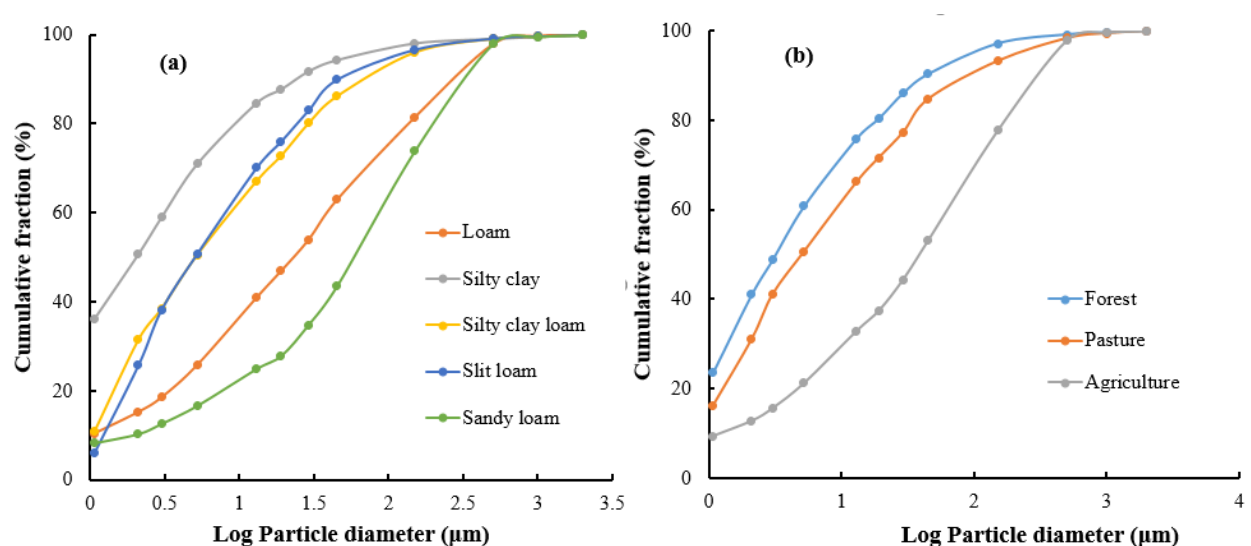
Figure 4. Log-long plots for PSD of sampled soils, ( a ) soil texture, ( b ) land type.